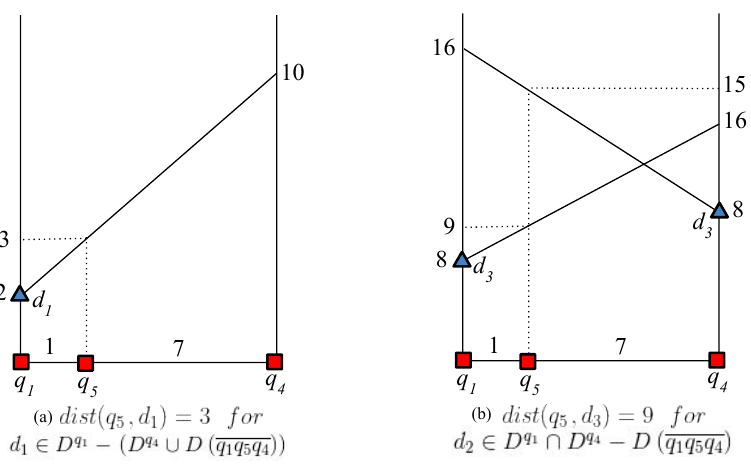
Figure 6. Computing distance from q 5 to d ∈ { d 1 , d 3 }